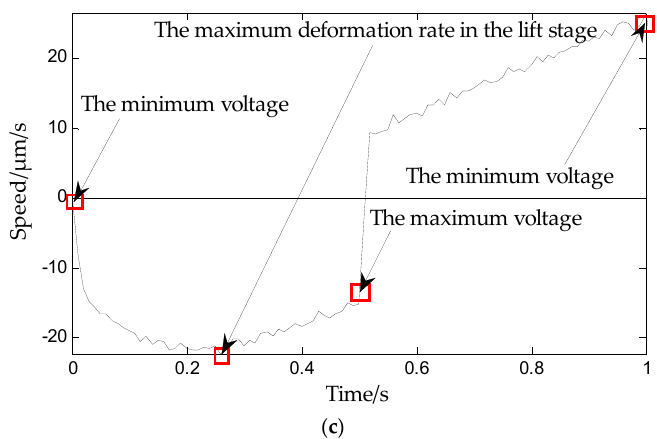
Figure 6. Deformation rate of piezoelectric actuators at an applied triangle wave voltage of 150 V and a frequency of ( a ) 0.2 Hz; ( b ) 0.4 Hz; ( c ) 1 Hz. Below the timeline, the voltage is loaded from the minimum voltage (0 V) to the maximum voltage (150 V). Above the timeline, the voltage drops from the maximum voltage (150 V) to the minimum voltage (0 V).